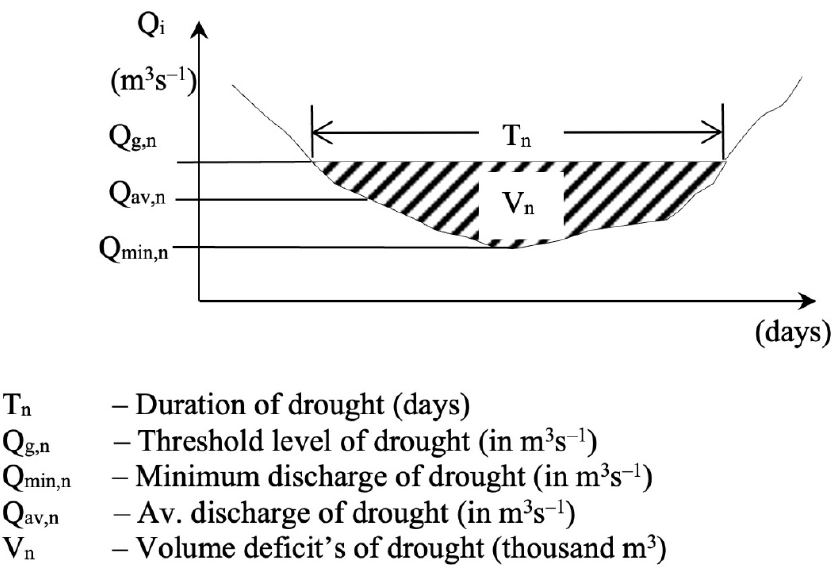
Figure 3. Parameters of streamflow